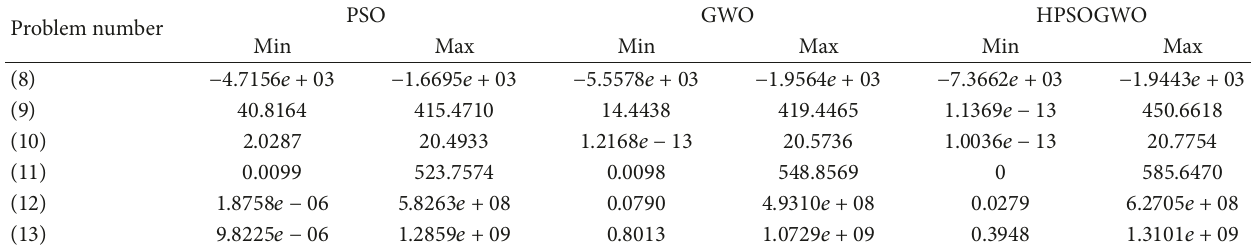
Table 6: PSO, GWO, and HPSOGWO numerical results of multimodal benchmark functions.